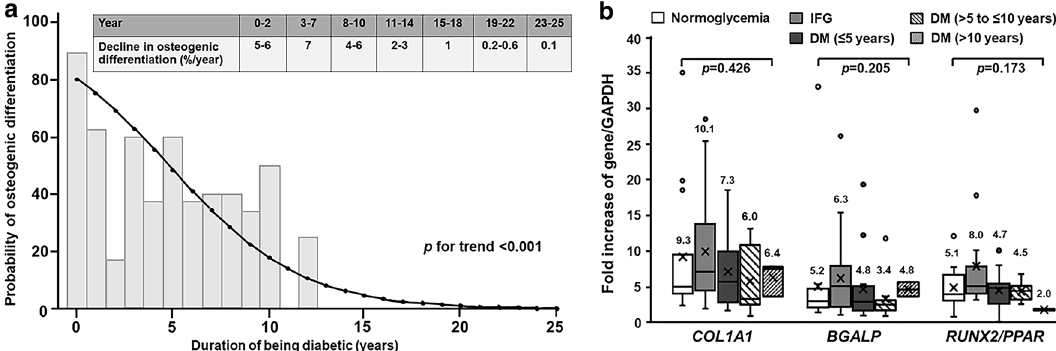
Figure 1. Decline in osteogenic differentiation potential along the progression of type 2 diabetes. ( a ) The probability of osteogenic differentiation impairment along the duration of being diagnosed as diabetic in participants with T2DM. The rate of osteogenic differentiation decreased 4–7% annually during the first 10 years of diagnosis and then decreased at a slower rate. ( b ) The expression of osteogenic differentiation markers in participants who showed a preserved osteogenic differentiation ability . Box and whisker plots to show a comparison of the expression of osteoblast-specific genes among five groups of participants, including normoglycemic, prediabetic, diabetic for less than 5 years, diabetic for less than 10 years and diabetic for longer than 10 years. All groups had comparable levels of osteoblast-specific gene expression, including BGALP ( p = 0.426) , COL1A1 ( p = 0.205), and RUNX2/PPARγ ratio ( RUNX2/PPAR ) ( p =